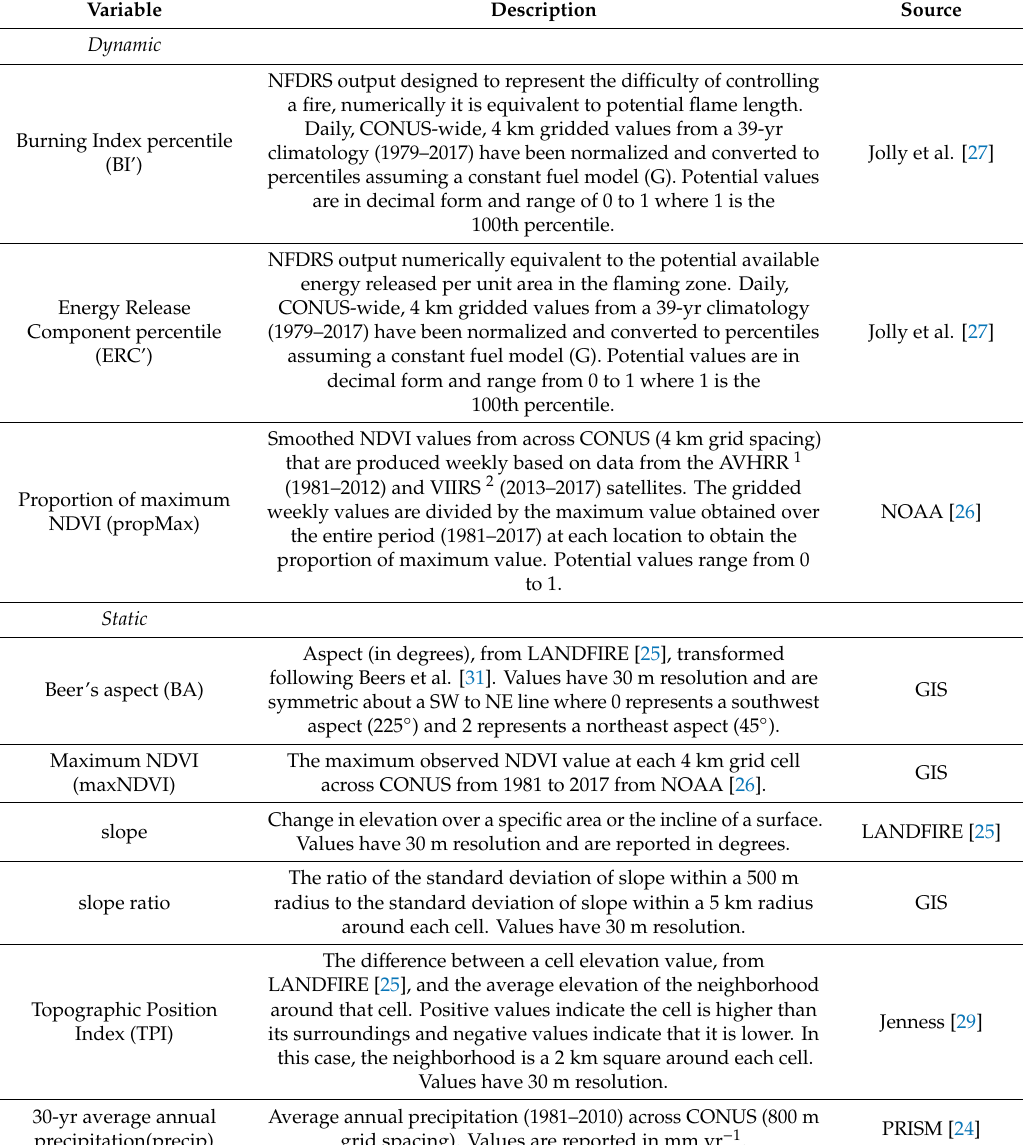
Table 2. Environmental variables used to assess commonalties among US wildland firefighter entrapments across the conterminous United States (CONUS). Dynamic variables vary either daily, i.e., the National Fire Danger Rating System (NFDRS) components [30], or weekly, i.e., the Normalized Di ff erence Vegetation Index (NDVI) proportion of maximum values. Some of the data were calculated using a Geographic Information System